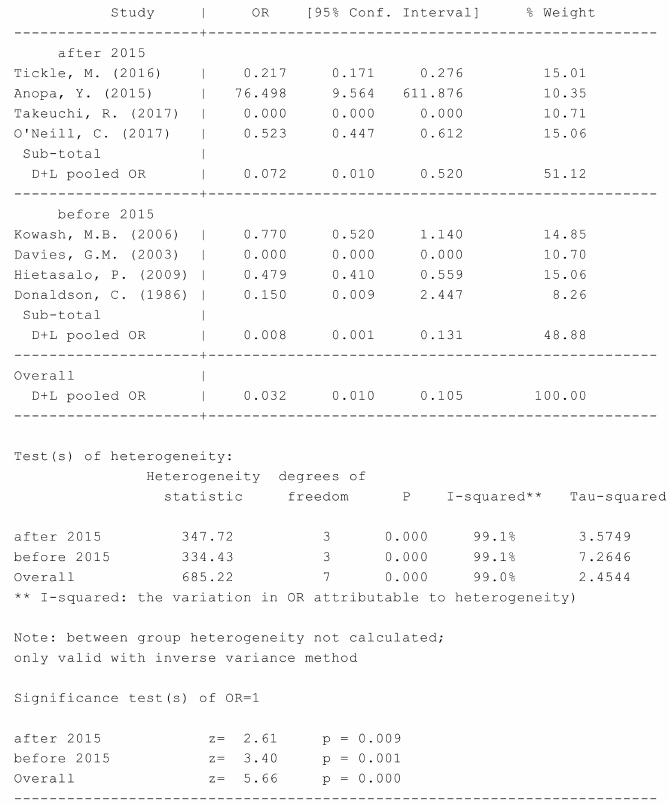
FigureA5. STATAdo-filesforanalysisofFigure6. “metanDMFTinterventionCostintervetion, DMFTcontrol Costcontrol, label (namevar = Author, yearvar = year) by (One less than 2015 two 2015 onwards) random or”